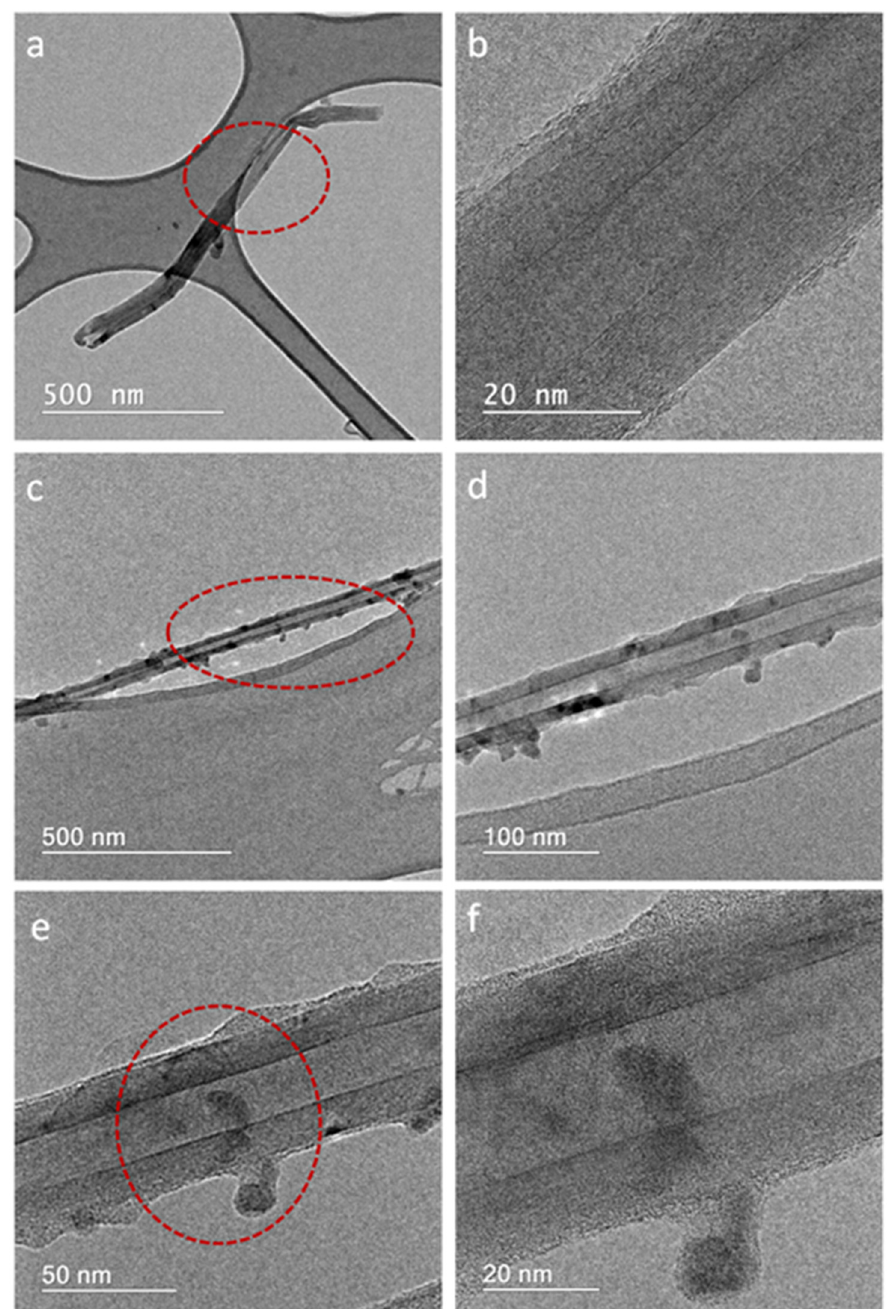
Figure 8. TEM images of BNNTs ( a , b ) and Cu-BNNTs ( c – f